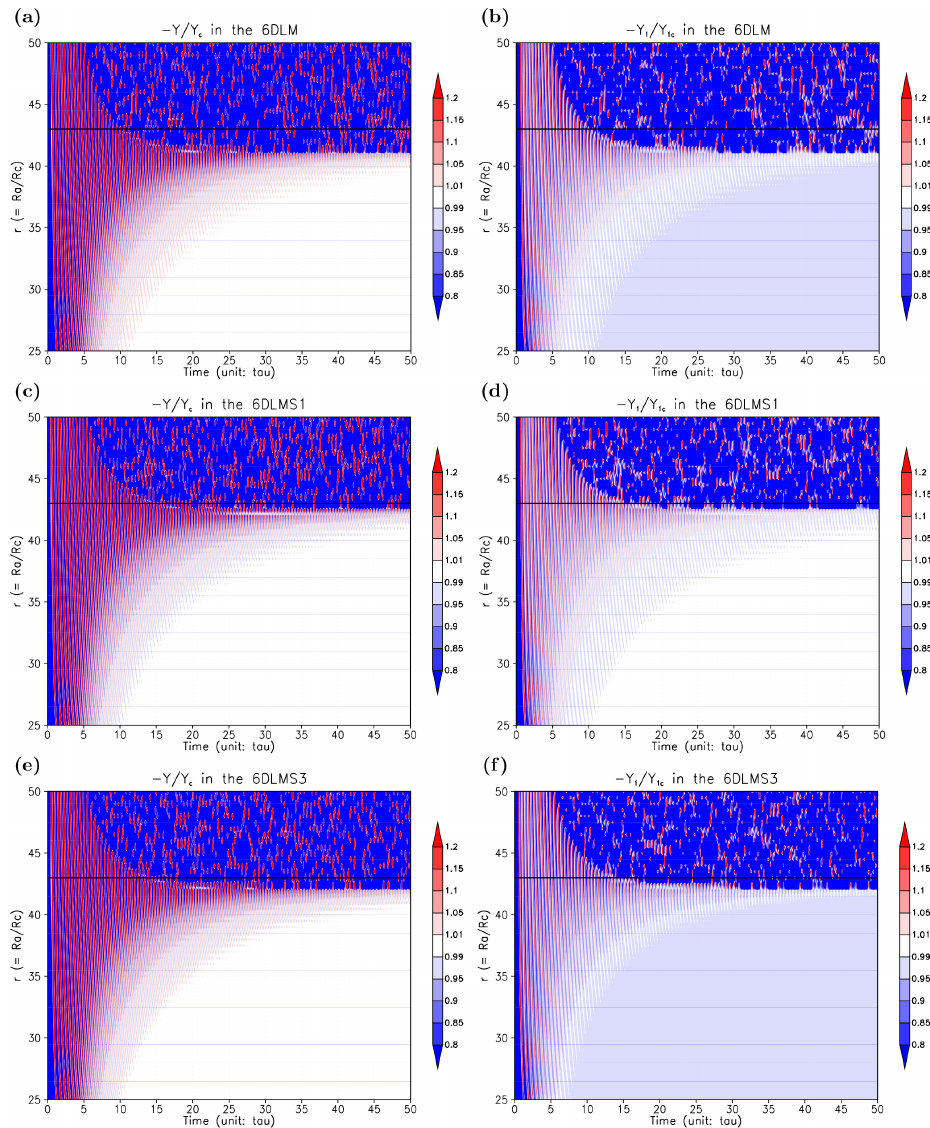
Figure 6. The r -time diagram of numerical solutions from the 6DLM (a, b) , 6DLMS1 (c, d) , and 6DLMS3 (e, f) . r ranges from 25 to 50 with (cid:49)r = 0 . 5. (a, c, e) show − Y/Y c , and (b, d, f) show − Y 1 /Y 1c . Y c and Y 1c are the critical points of the 5DLM as defined in Eq. (19) of Shen14. The black line indicates a constant value of r =